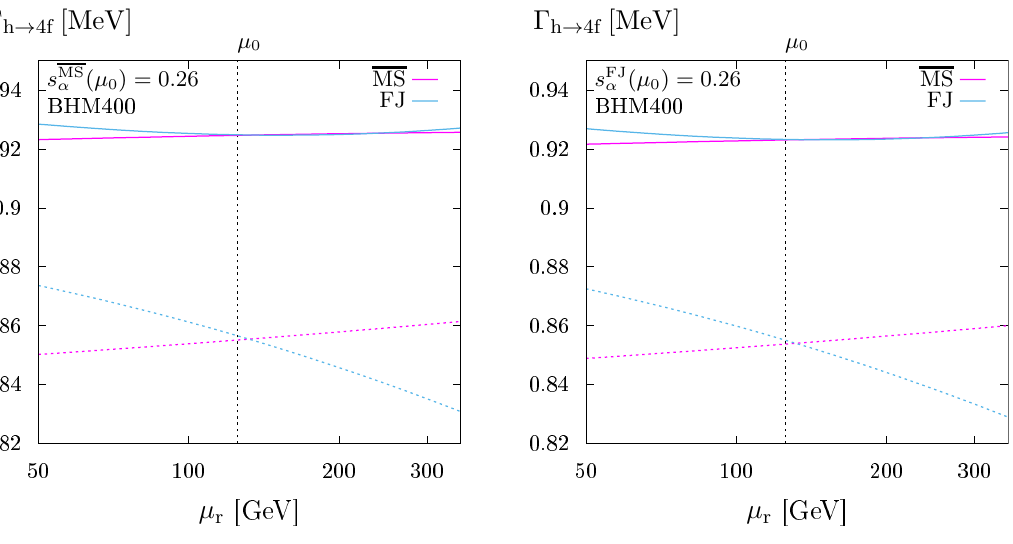
Figure 31 . As in (cid:12)gure 10, but for benchmark scenario BHM400.